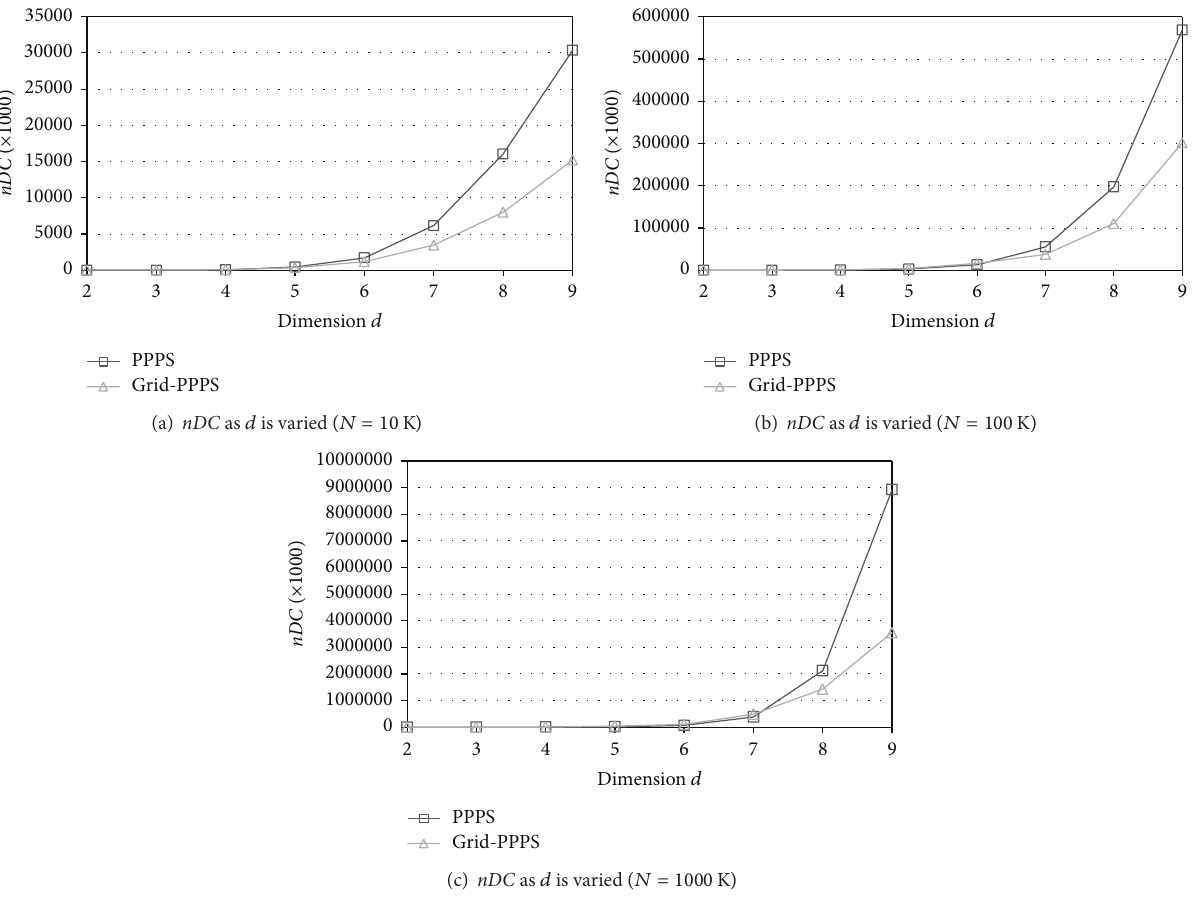
Figure 7: The comparison of the nDC and 𝑑 and 𝑁 are varied related to Experiment